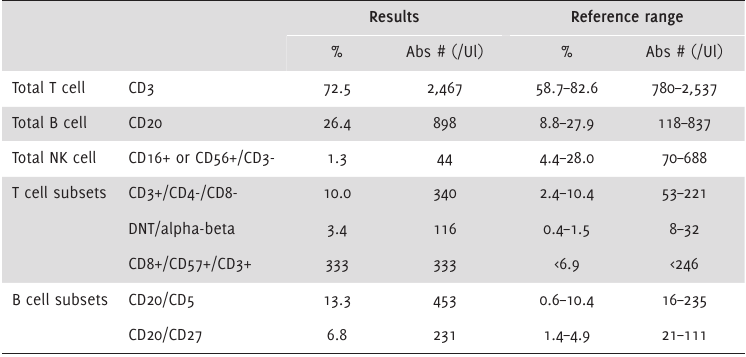
Total NK cell CD16+ or CD56+/CD3-